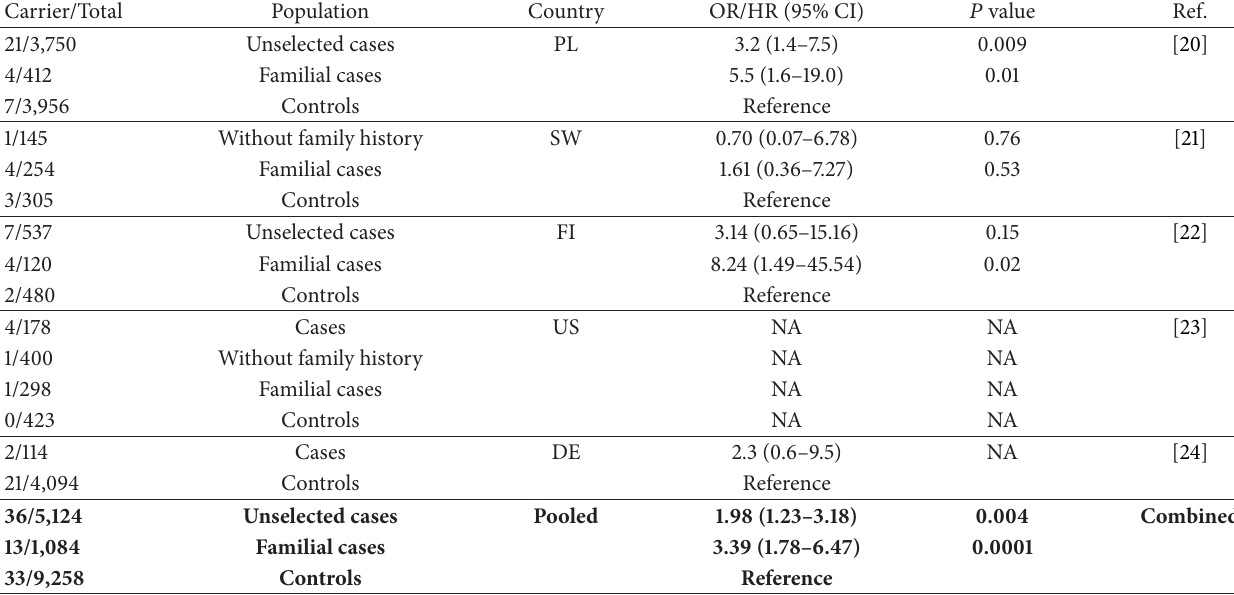
Table 1: Characteristics and results of 5 prostate cancer studies.